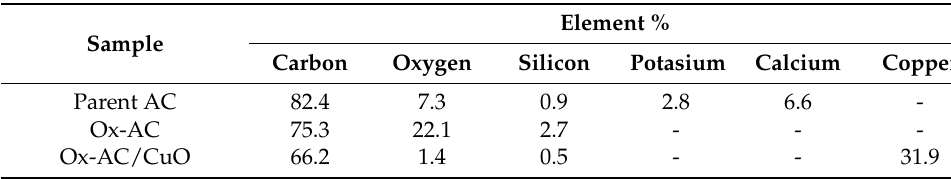
Table 1. EDS analysis for parent AC, Ox-AC, Ox-AC/Cu/Cu 2 O/CuO.